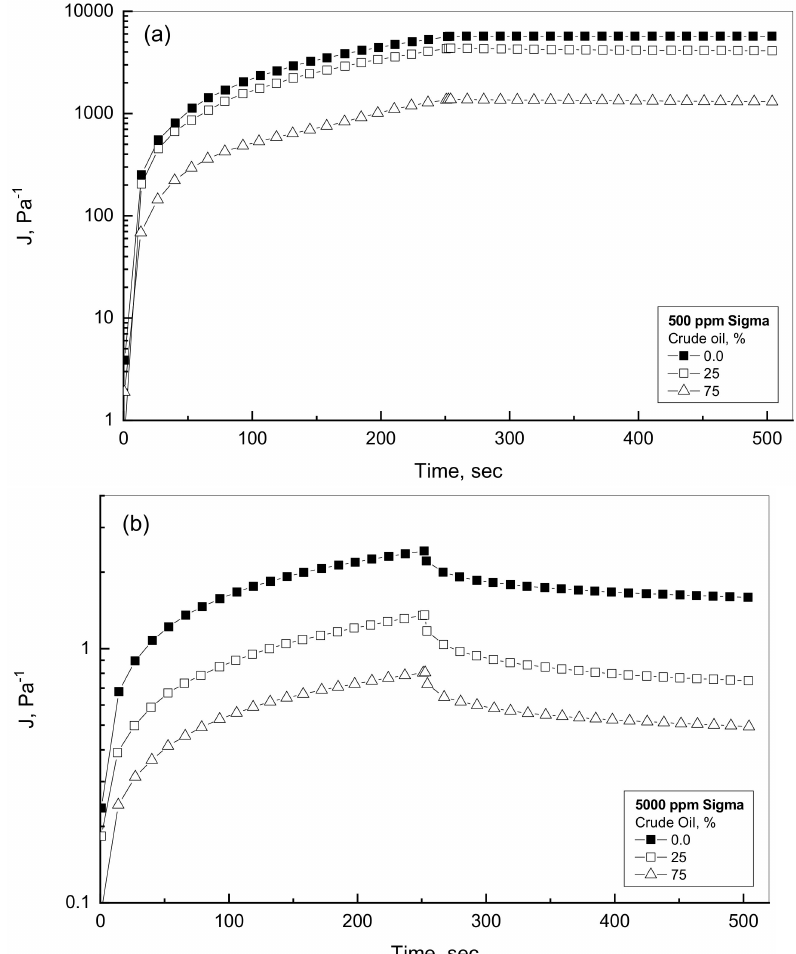
Figure 6. Effect of oil addition for 500 and 5000 ppm of Sigma emulsions. ( a ) Low Sigma concentration; ( b ) High Sigma